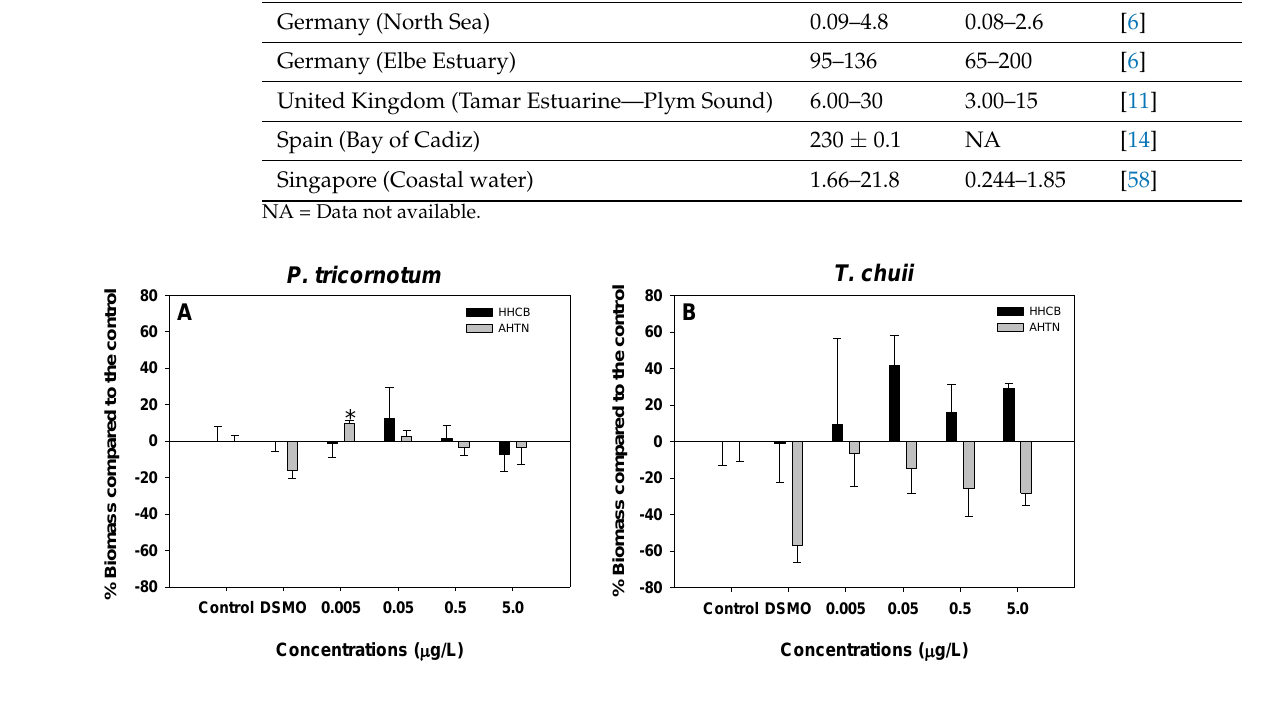
Table 1. Measured Environmental Concentrations (MEC) of Galaxolide (HHCB) and Tonalide (AHTN) in seawater from different locations. Measured values are in ng/L. Maximum values (bold) were used in calculating risk quotient (RQ).